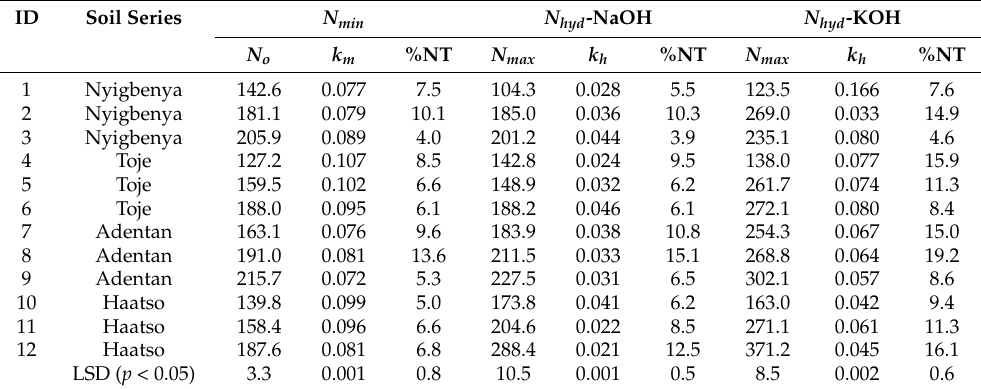
Table 2. First-order kinetic parameters of N mineralization/hydrolysis for the soils